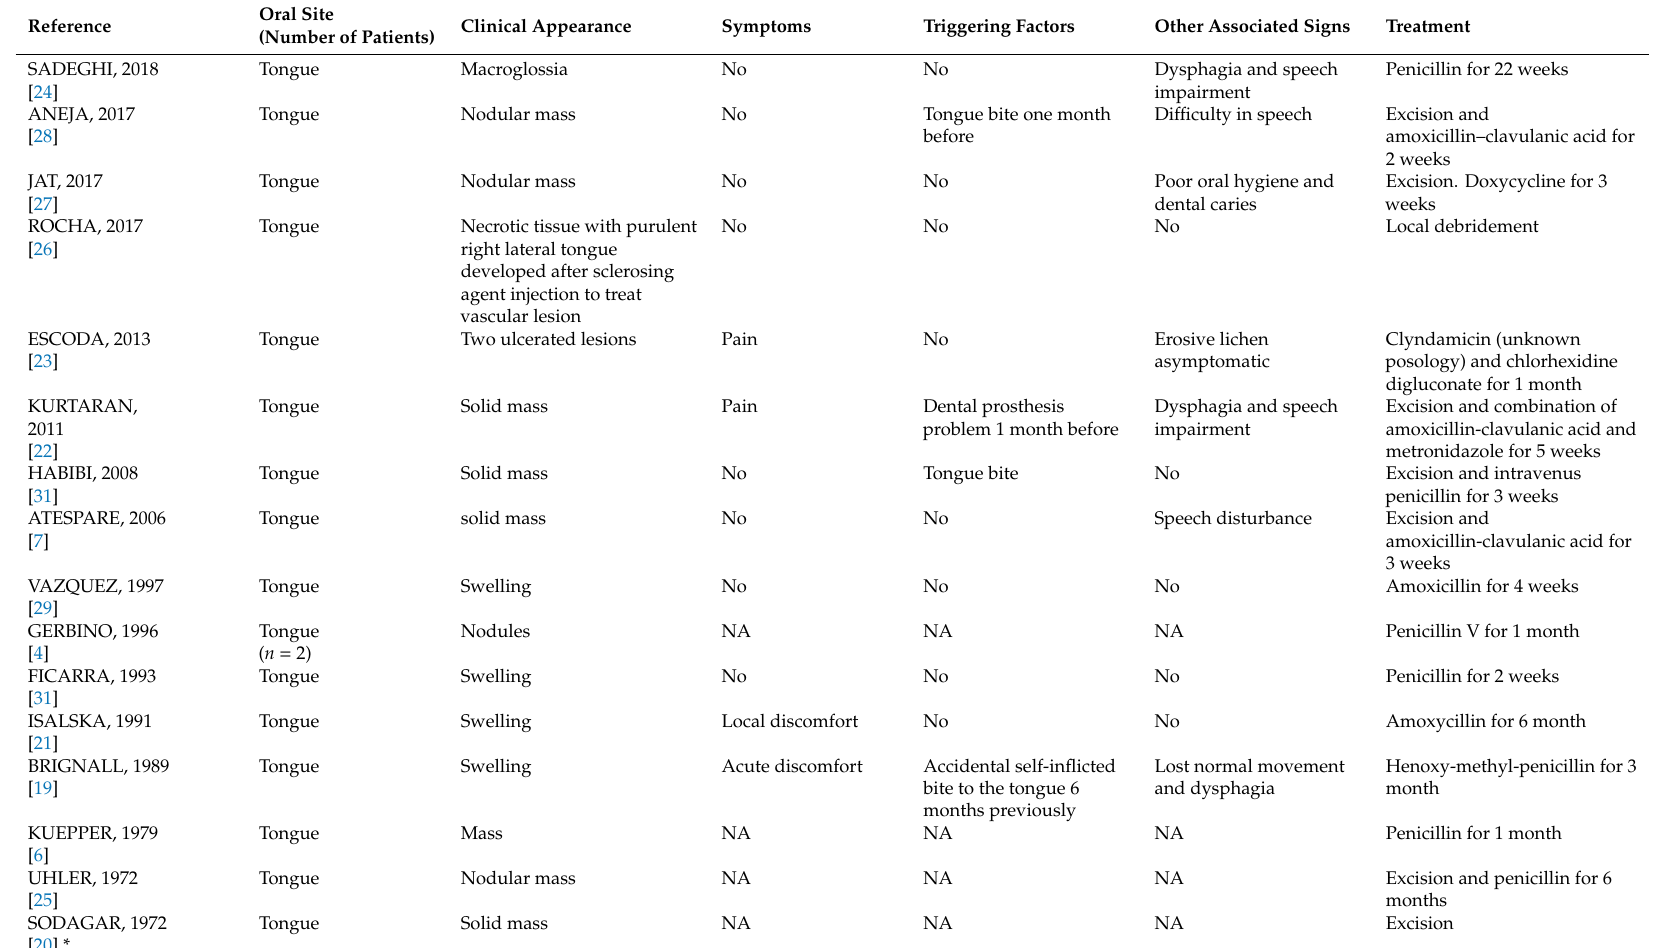
Table 1. Studies reporting cases of actinomycosis of the